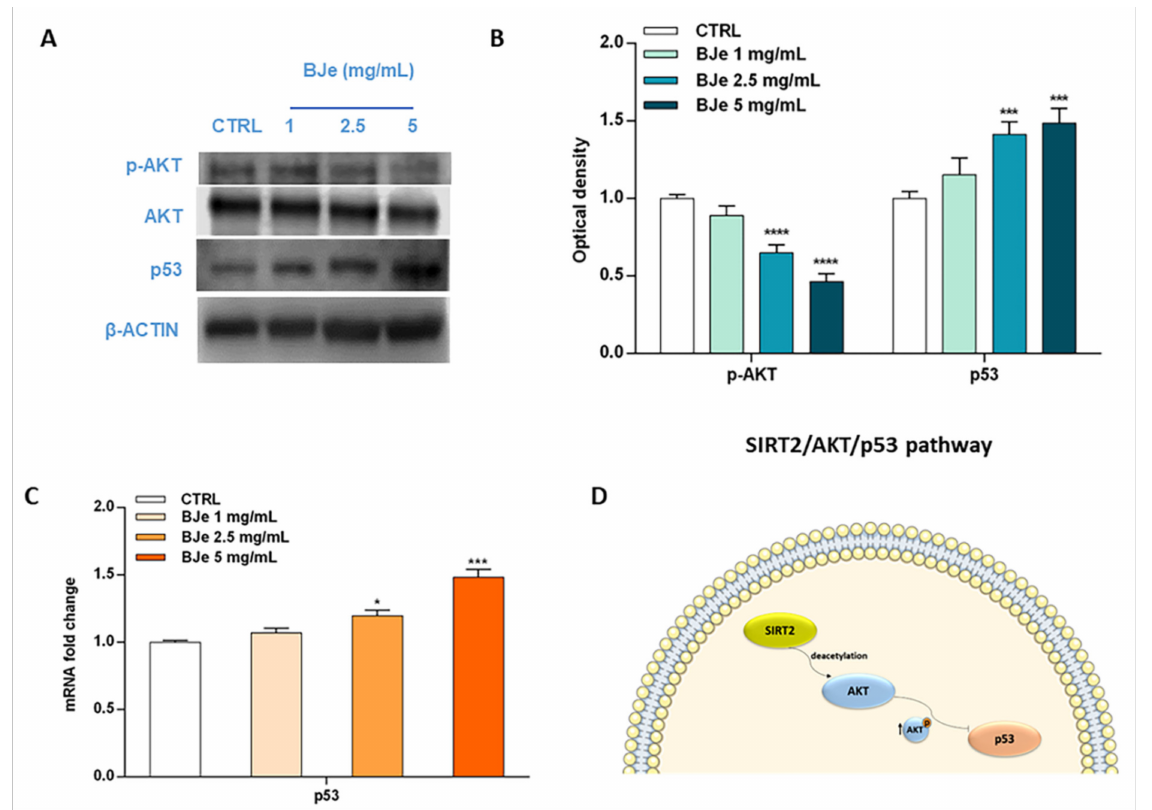
Figure 10. Phosphorylation of AKT along with gene and protein expression of p53 modulated by BJe in THP-1 treated cells. Cells were exposed to different concentrations (1–5 mg/mL) of BJe for 12 h and 24 h, prior being processed for gene analysis by RT-PCR as well as for protein expression studies by Western blotting, respectively. A representative immunoblot of three independent experiments is shown ( A ). Densitometric analysis of bands from three independent blots is presented ( B ). Results are expressed as ratio of phosphorylated form with respect to total protein (p-AKT/AKT), while the expression of p53 was normalized against β -actin. Protein levels are extrapolated as values detected in the untreated cells (CTRL), which are arbitrarily assigned as 1. The gene expression of p53 was quantified by RT-PCR analysis and calculated by the 2 – ∆∆ CT method, with β -actin as housekeeping gene. Results are expressed as fold change compared to the untreated cells ( C ). Data, represented as mean ± SEM, report the values obtained in three different sets of experiments for Western blotting ( n = 3), while made in triplicate for RT-PCR ( n = 9). * p < 0.05, *** p < 0.001, and **** p < 0.0001 vs. CTRL. The putative mechanism of action of BJe involving SIRT2/AKT/p53 pathway is depicted ( D